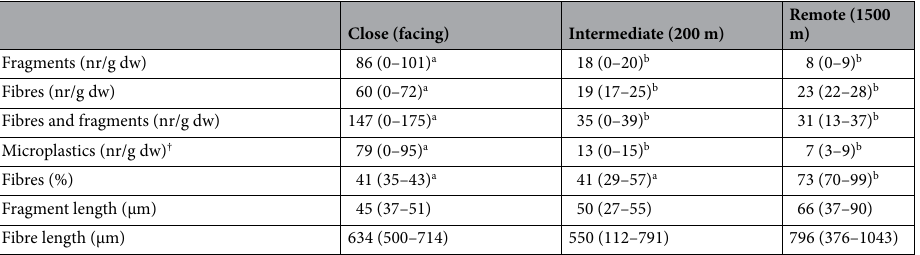
Table 1. Median values (95% Confidence Interval) of anthropogenic fragments and fibres, and microplastics accumulated by the lichen Flavoparmelia caperata at sites located at distance from the landfill. Different letters indicate statistically significant (P < 0.05) differences. † Estimated using the proportion of fibres and fragments that were identified as plastic, 54% at close sites, 38% at intermediate, and 23% at remote